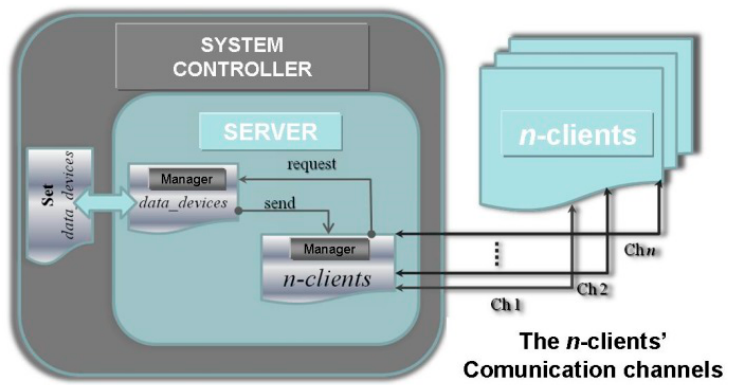
Figure 8. General diagram of the remote system communication.